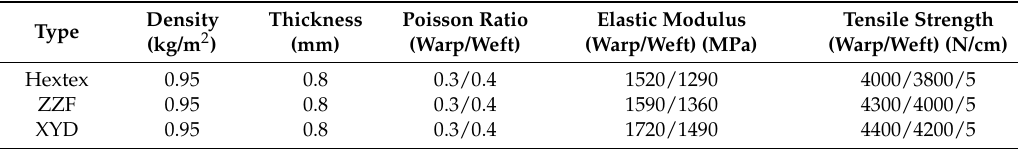
Figure 7. The stress-strain curves of membrane materials.